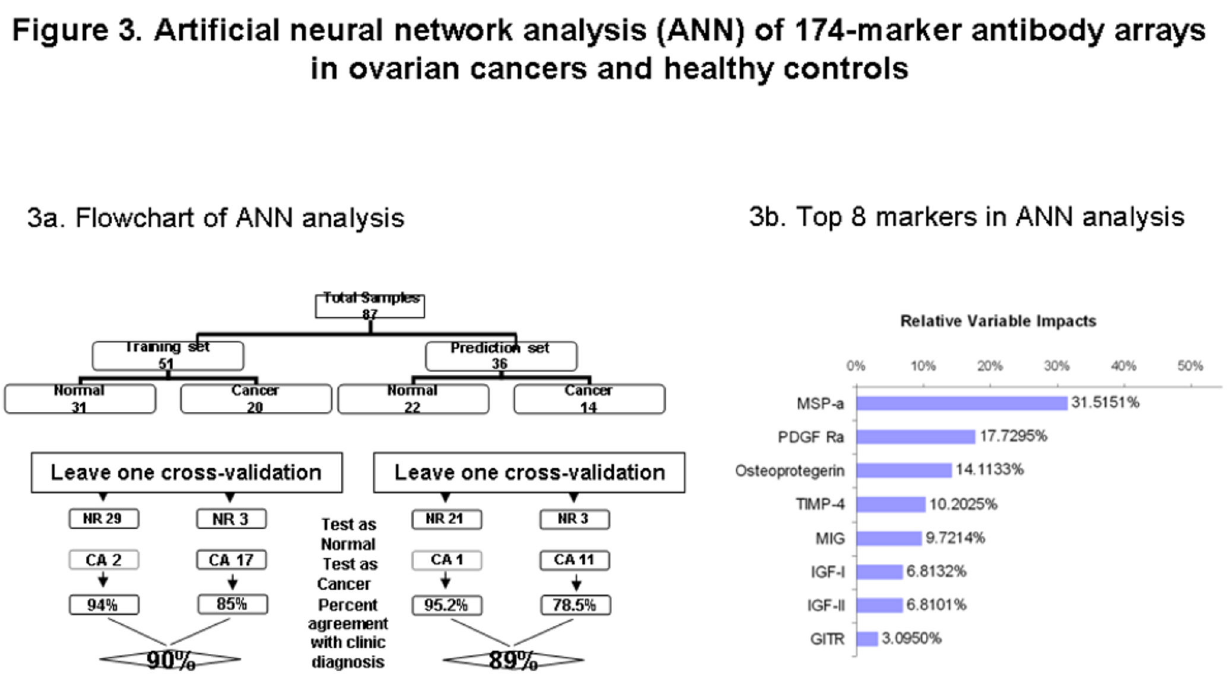
Figure 3. Artificial neural network analysis of 174-marker antibody array results in ovarian cancers and healthy controls. 3a. Artificial neural network analysis of 174-marker antibody array results comparing ovarian cancers and healthy controls. Samples representing both the training set and prediction set are depicted in the graph. 3b. The top 8 markers with the greatest impact in artificial neural network analysis of 174-marker antibody arrays in ovarian cancers and healthy controls are